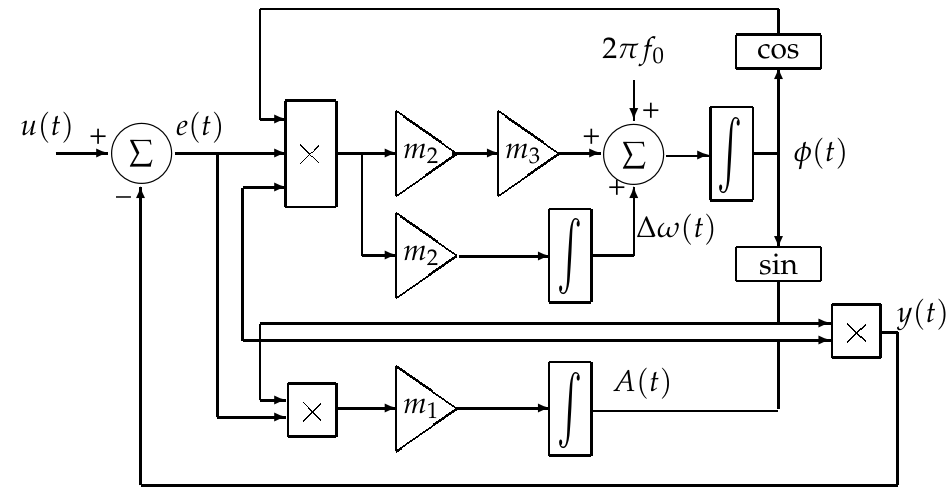
Figure 2. Block diagram of the nonlinear adaptive